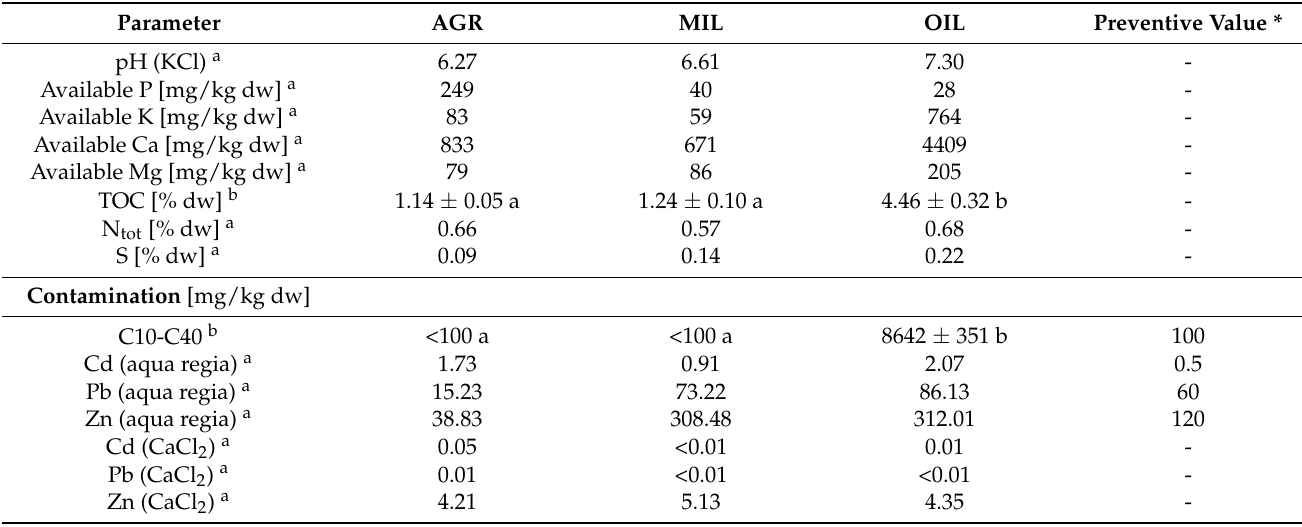
Table 1. Characterization of soils used in the experiment (sample of homogenized soil prepared before planting; a n = 1, b mean ± SD, n = 4), the same letters behind values mark comparable results ( p < 0.05).